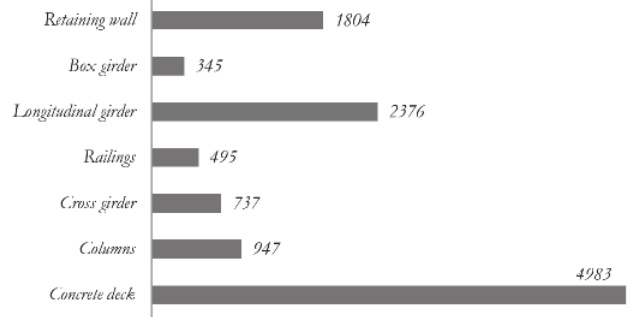
Damage frequency by structural RC element of DNIT bridges